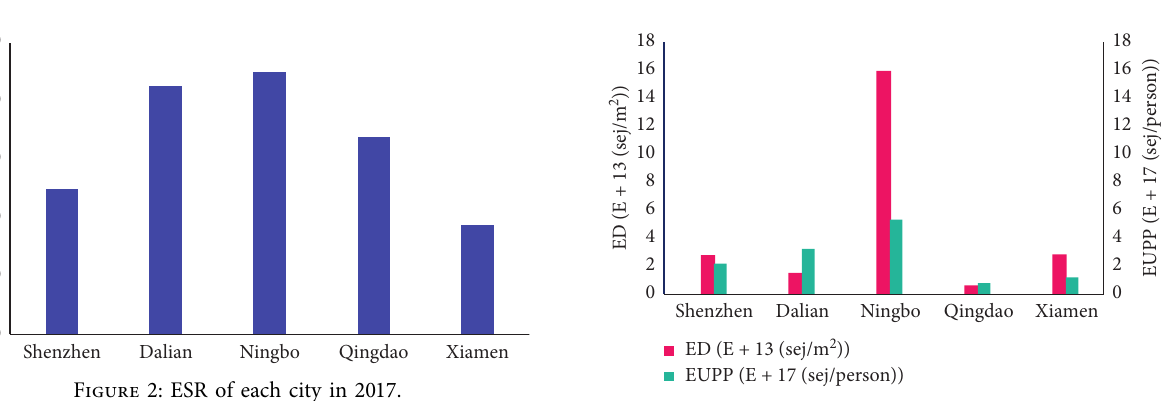
Figure 3: ED and EUPP in each city in